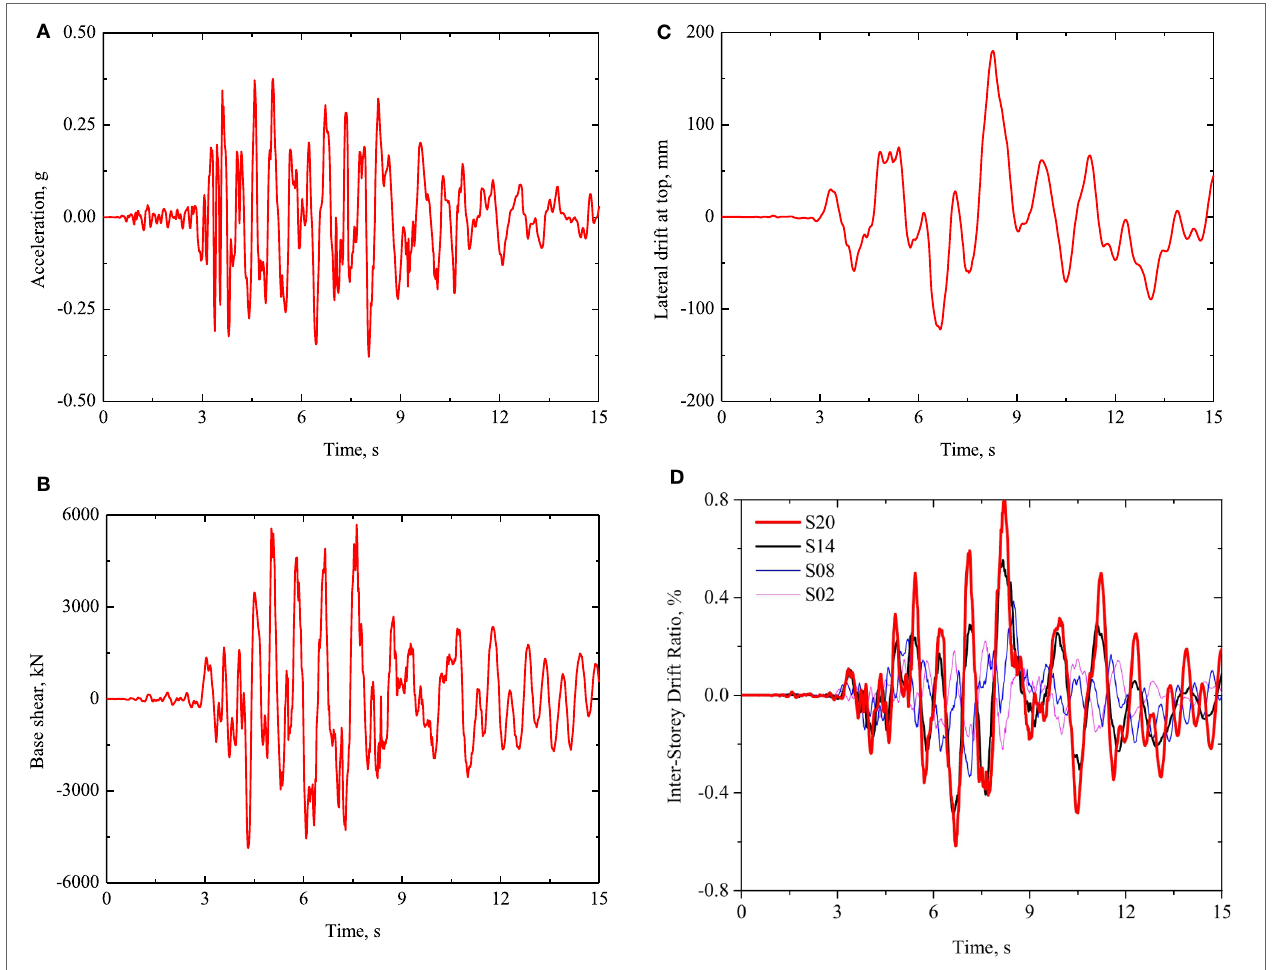
FigUre 11 | Seismic response of the finite element model: (a) scaled earthquake acceleration (NGA #: 1602), (B) base shear, (c) lateral drift at top, and (D) inter-storey drift ratios: S02, S08, S14, and S20 represent the 2nd, 8th, 14th, and 20th